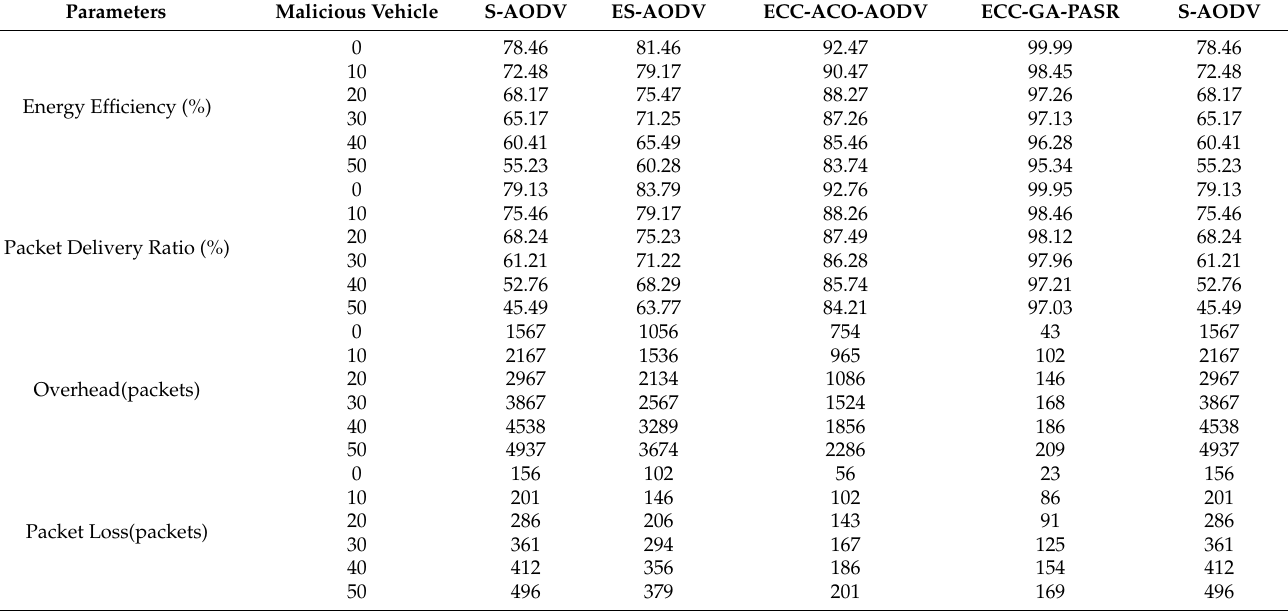
Table 9. Performance Analysis of Energy Efficiency, Packet Delivery Ratio, overhead, and Packet Loss concerning increase in malicious vehicles.